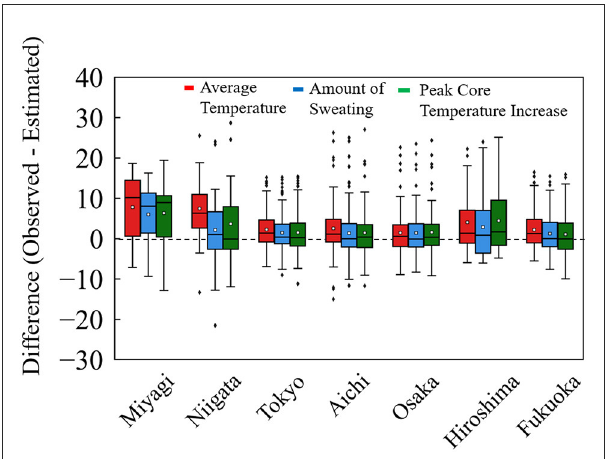
FIGURE6 Difference from observed to estimated patients per million population in the days of WBGT ≥ 31 ◦ C. This approximately corresponds to a rate of transported patients per million population of ≥ 10 in seven prefectures from 2013 to 2019.